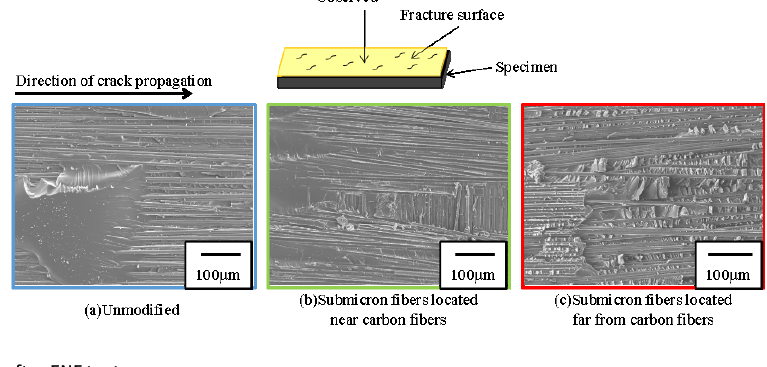
Figure 5: Fracture surface after ENF test.